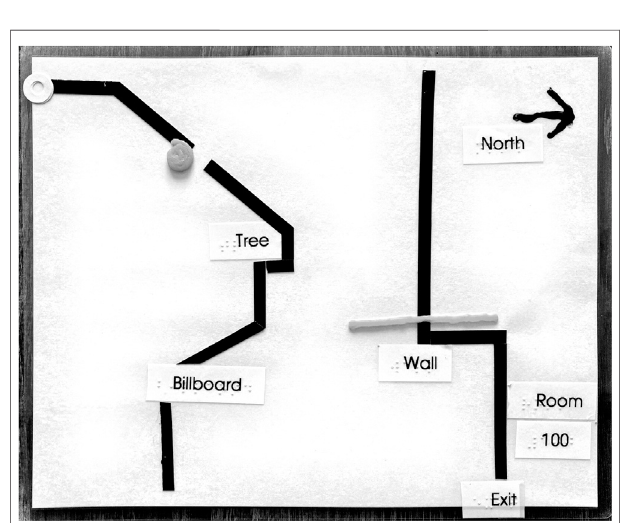
FIGURE 6 | Representation of the tactile map that was provided to the participant for Route C. The outdoor segment of the route was captured on the left side of the tactile map and the indoor segment on its right. The tactile map was letter-sized and crafting materials representing a garbage can and a public bench were added to the map on the prompt of the